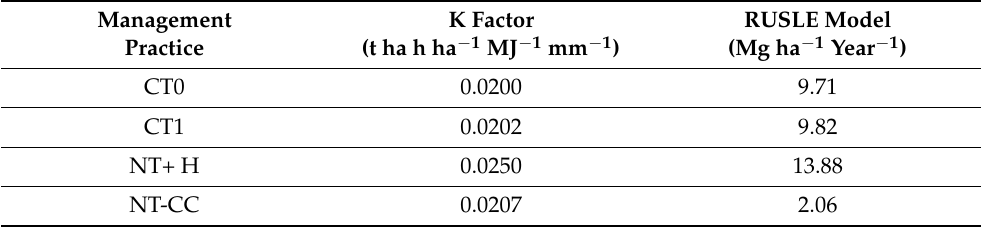
Table 3. Soil loss predicted by the RUSLE-Model. Initial situation (2004) and final situation (2019).